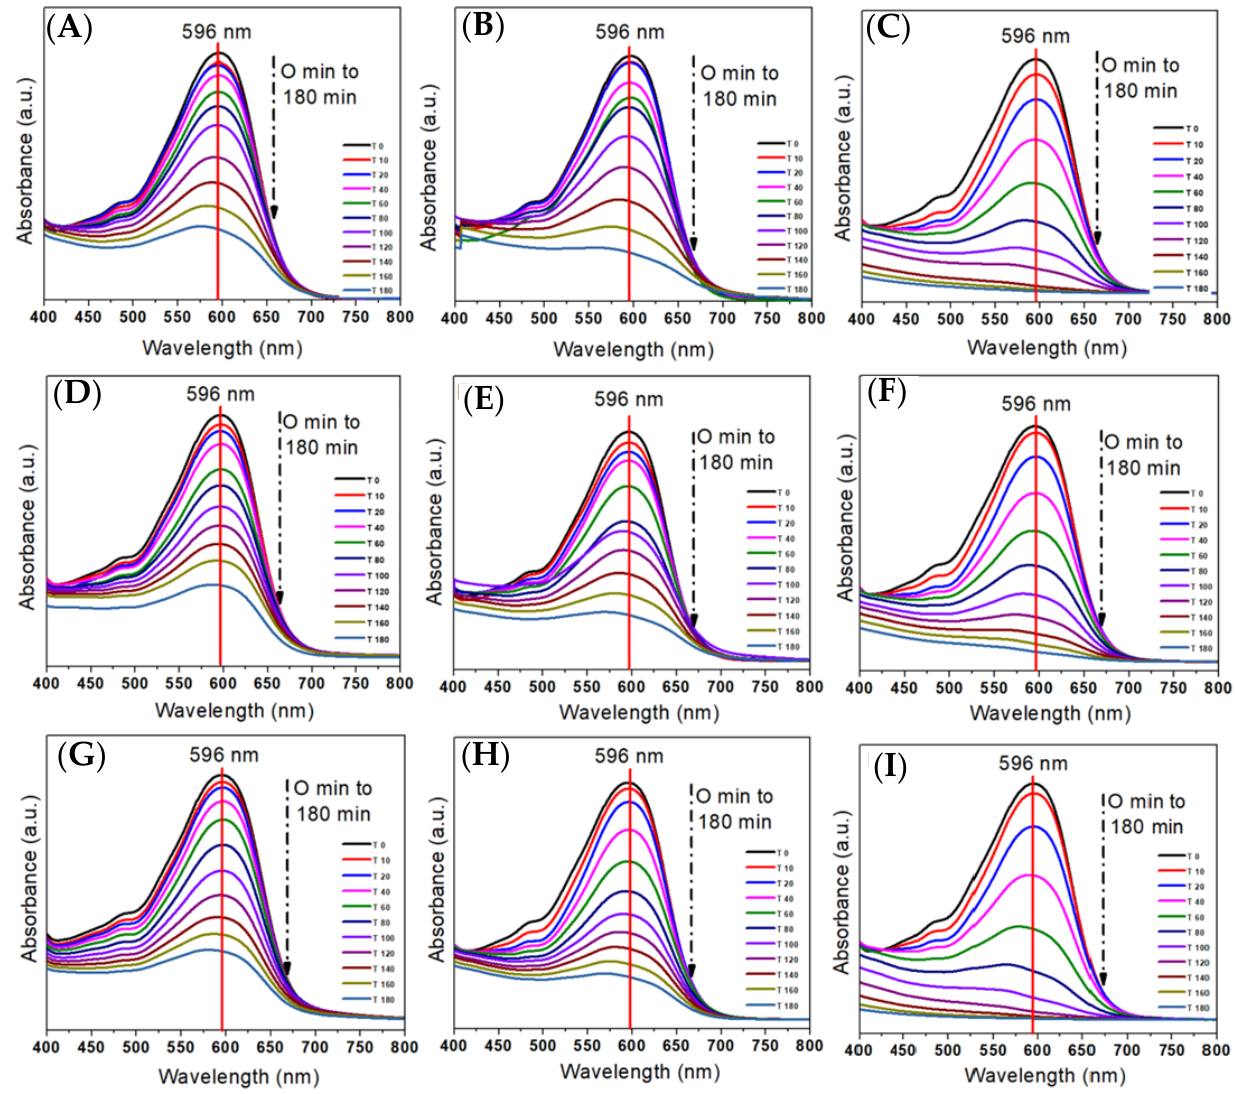
Figure 7. Absorption spectra of RB5 catalyzed by ( A – C ) Ni50-Fe50 wt%, ( D – F ) Ni80-Fe20 wt%, and ( G – I ) Ni90-Fe10 wt% samples.